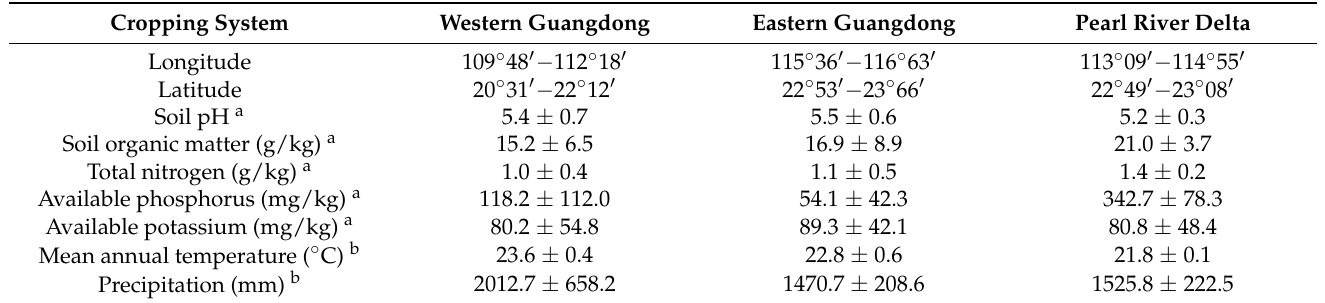
Table 1. Location, soil, and climate characteristics of sampled farms for sweet-potato-based produc- tion system in this study.